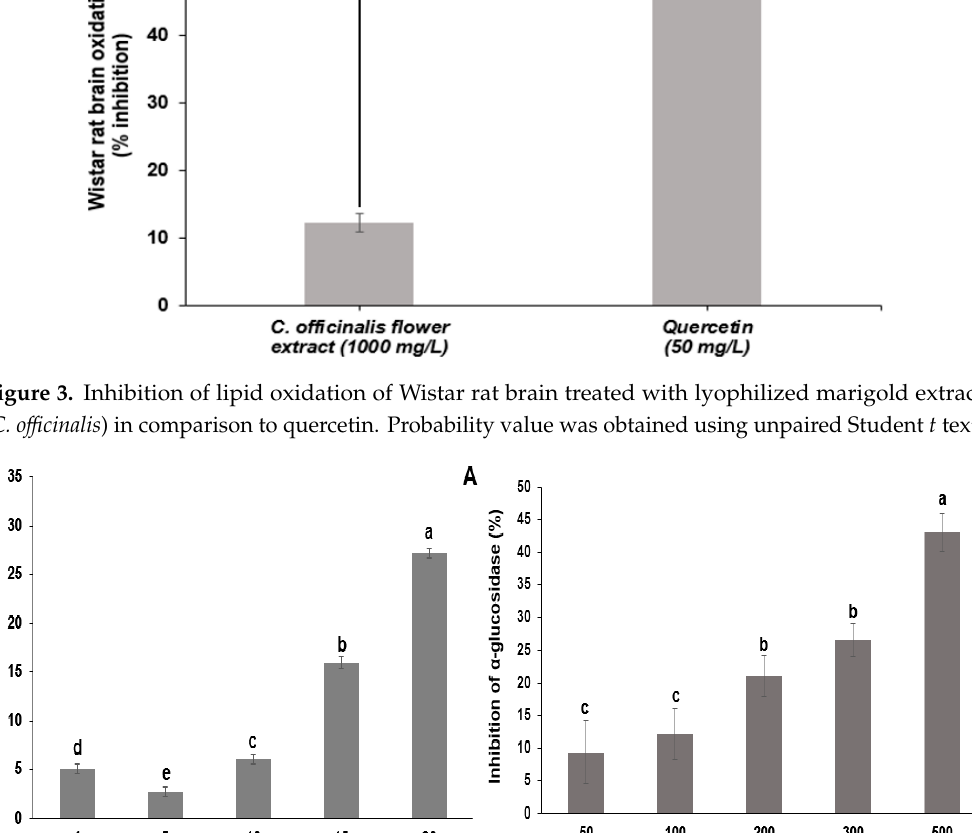
Figure 3. Inhibition of lipid oxidation of Wistar rat brain treated with lyophilized marigold extract ( C. officinalis ) in comparison to quercetin. Probability value was obtained using unpaired Student t text.